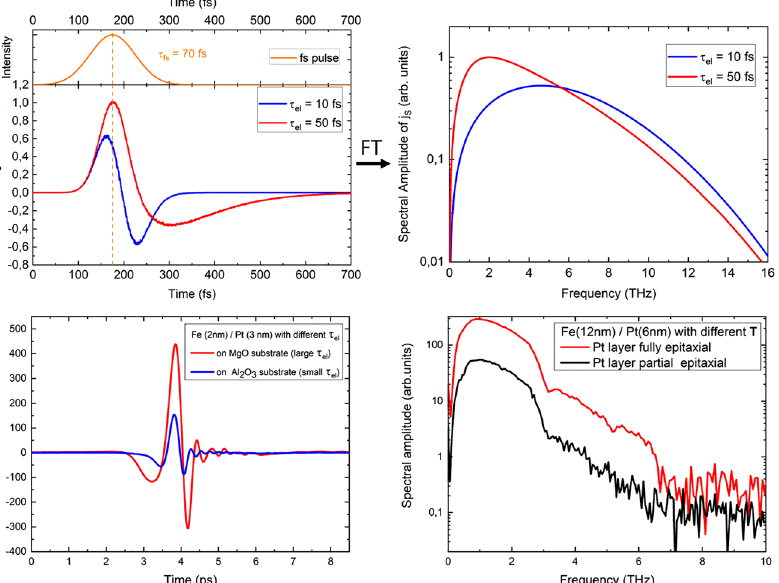
Figure 7: Dependence of the THz emission on the structural quality of the interface. (Upper panel-Left) Numerical simulations of the Boltzmann transport equation for an Fe/Pt spintronic emitter for different elastic scattering lifetimes τ el . The temporal evolution of the laser pulse intensity with a length of 70 fs is also shown on top. (Upper panel-Right) Spectral amplitudeofthesimulatedspincurrent(andconsequentlyofthechargecurrent)insidePtlayerobtainedbytheFouriertransformofthepulses on the left. (Lower panel — Left) Experimental THz-E- fi eld amplitudes for Fe/Pt samples with different τ el as detected after traveling the optical beam path of a THz-TDS setup. (Lower panel — Right) Experimental spectra amplitudes of Fe/Pt heterostructures with different interface transmissions T . Figure modi fi ed from the study by Nenno et al.